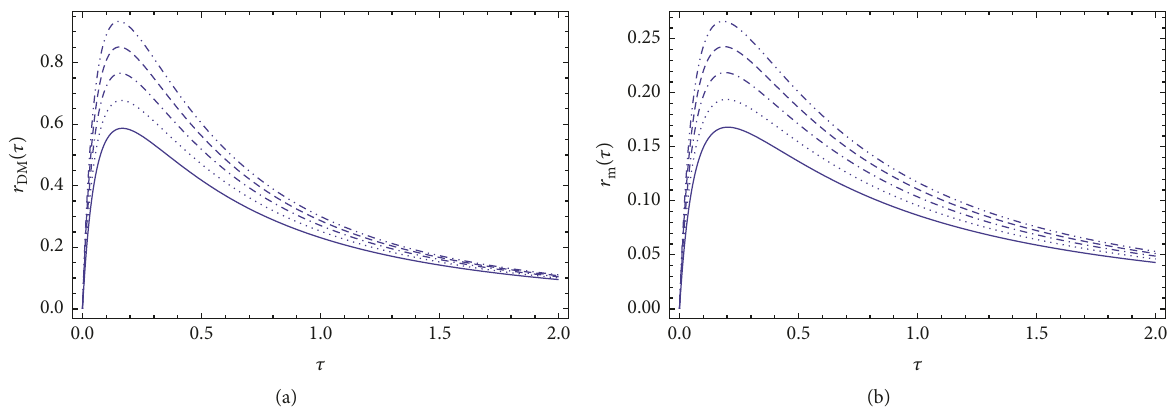
Figure 5: Time variation of the dark matter energy density (a) and of the radiation (b) during the reheating period in the presence of an exponential scalar field potential, for different values 𝛼 𝜙 of the decay width of the scalar field: 𝛼 𝜙 = 1.15 (solid curve), 𝛼 𝜙 = 1.35 (dotted curve), 𝛼 𝜙 = 1.55 (dash dotted curve), 𝛼 𝜙 = 1.75 (dashed curve), and 𝛼 𝜙 = 1.95 (dash double dotted curve), respectively. For 𝑝 we have adopted the value 𝑝 = 5 . The initial conditions used to numerically integrate (102) are 𝜙(0) = 15 , 𝑢(0) = −5.5 , 𝑁 𝜙 (0) = 20 , 𝑟 DM (0) = 0 , and 𝑟 (0) = 0 , respectively. m